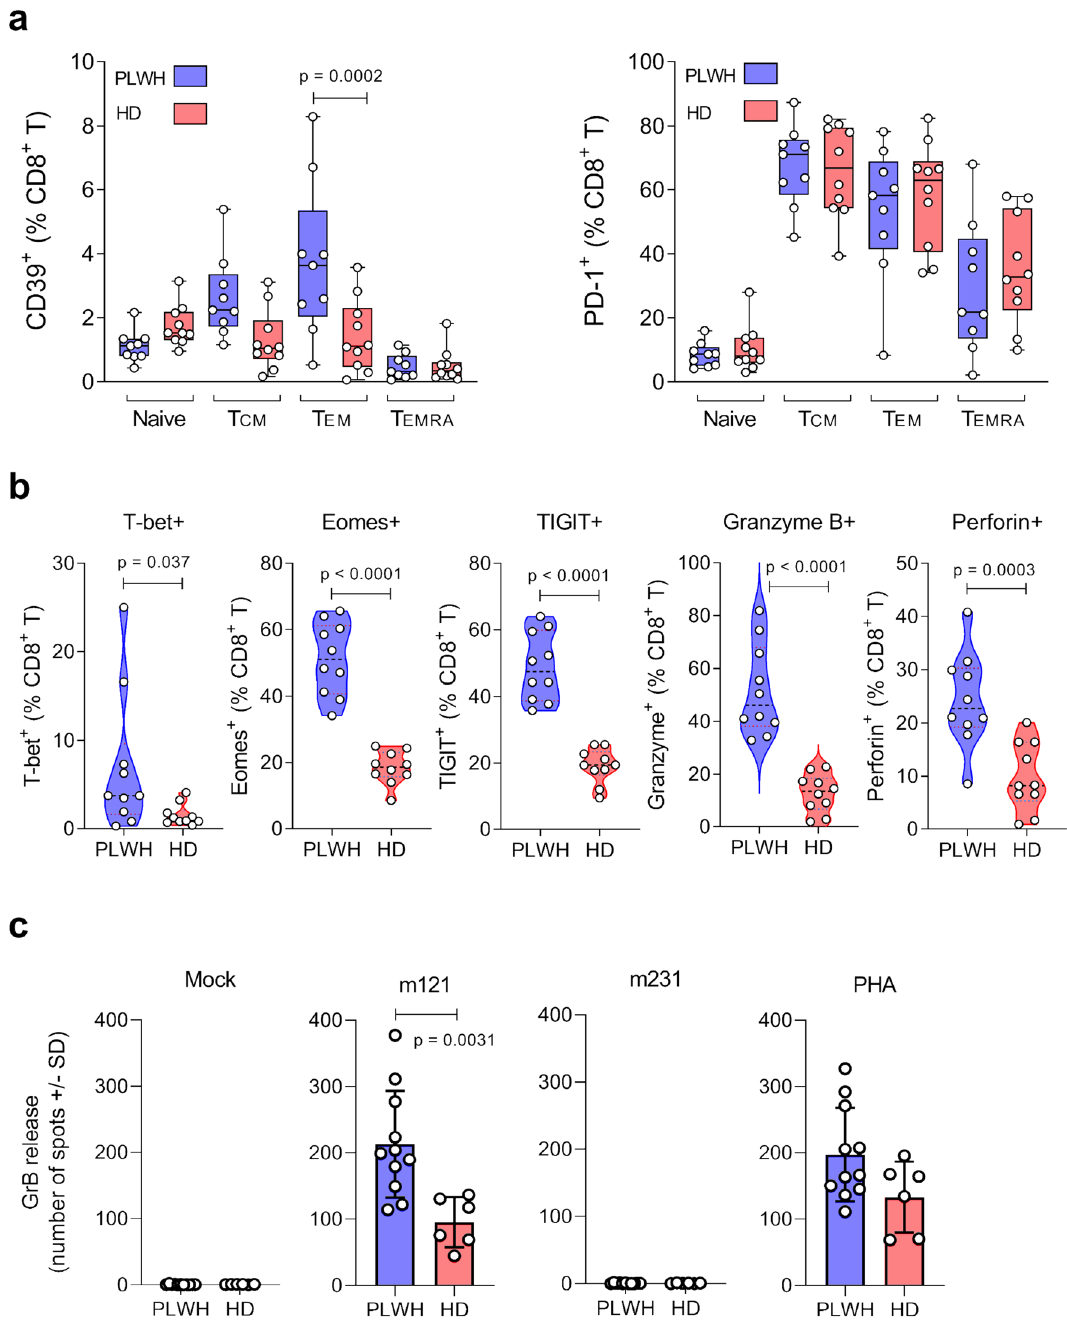
Figure 1. Phenotypic analysis of CD8 + T cells from people living with HIV and HIV-naïve donors. CD8 + T cells from a total of 26 virologically suppressed PLWH (PLWH, blue) and ten HIV-naïve donors (HD, red) were analysed for phenotype and/or production of granzyme B. ( a ) CD39 and PD-1 in naïve, T CM , T EM and T EMRA subpopulations and plotted as percentage positive of gated (PLWH, n = 10; HD, n = 10). ( b ) T-bet, Eomes, TIGIT, granzyme B and perforin in the CD3 + CD8 + population (ex vivo) and plotted as percentage positive in each population (PLWH, n = 9; HD, n = 10). ( c ) Granzyme B-producing cells in ex vivo PBMC (PLWH, n = 11; HD, n = 6) were quantified by ELISpot after culture in triplicate with SL9 peptide-pulsed T2 cells for 48 h (E:T = 1:1), together with m121 ImmTAV (0.5 nM), a non-binding control TCR fusion protein, m231 (1 nM) or no ImmTAV (mock); PHA stimulation was used as a positive control for cell viability. Negative control wells (no TCR) yielded spot-forming cell counts < 3/well in all subjects, for both peptide-pulsed and unpulsed conditions. Results are plotted as mean ± SD for each condition. Groups were analysed by Mann–Whitney test or 1-way ANOVA with Sidak’s multiple